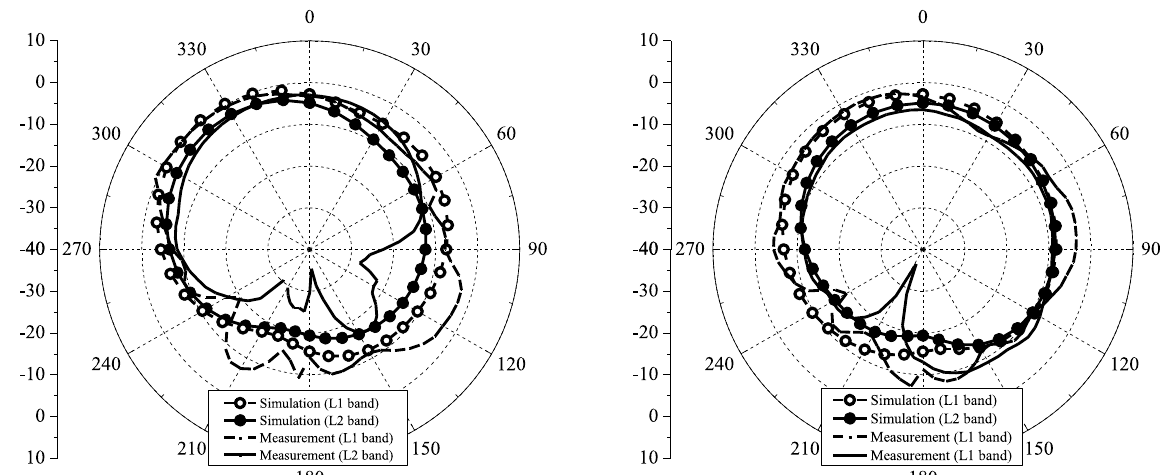
Fig. 16. Full-wave simulated and measured far- fi eld radiation pattern (a) y - z plane and (b) x - z plane.